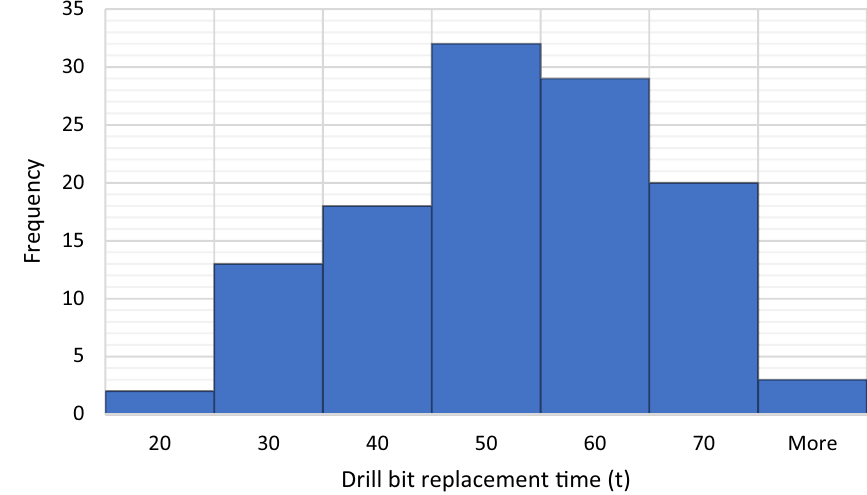
Fig. 3 Histogram of the failure times of 123 rotary drill tricone rock roller bits